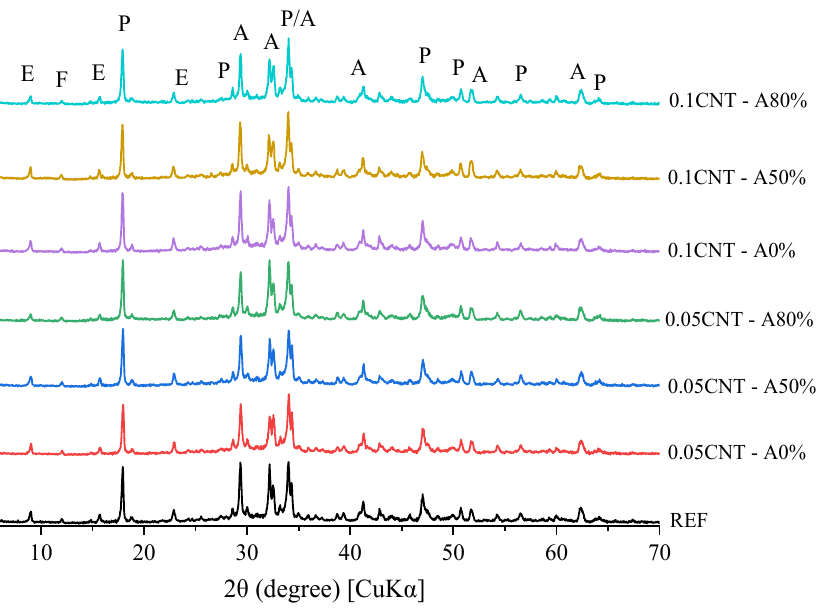
Figure 11. XRD patterns of cement pastes at 1 day of hydration (A—alite; E—ettringite; F—ferrite; P—portlandite).